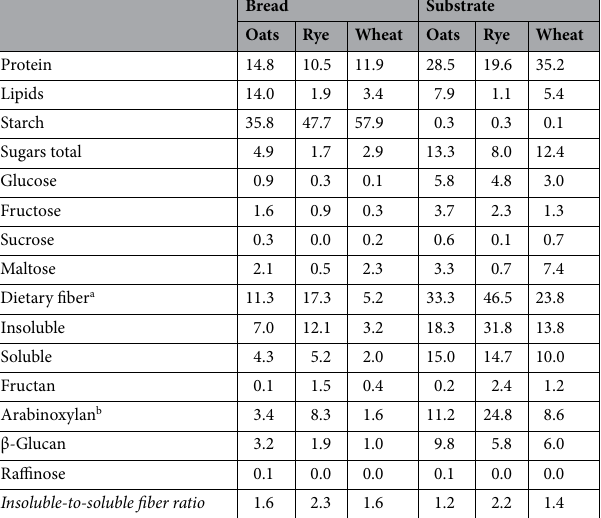
Table 1. Nutritional composition (% of dry matter) and the ratio of insoluble-to soluble dietary fiber of breads and fermentation substrates derived from the breads, analyzed in duplicate samples. a Calculated as the sum of fructan (AOAC Method 999.03) and dietary fiber analyzed by AOAC Method 994.13. b Calculated from arabinose, xylose and galactose residue values (analyzed by AOAC Method 994.13) assuming that arabinose to xylose ratio is 0.69 in